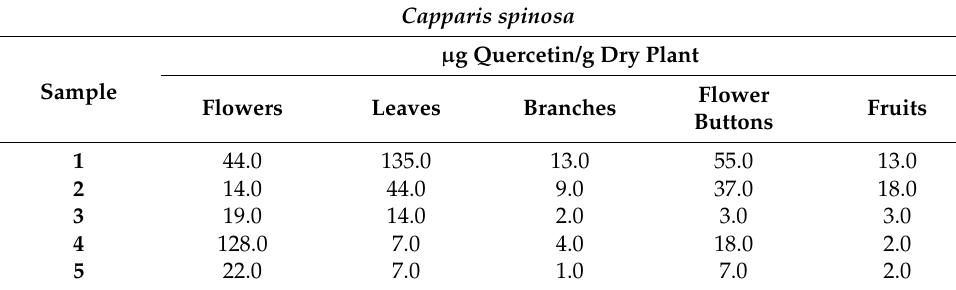
Table 3. Quercetin content ( µ g) in the epigean parts of C. spinosa .